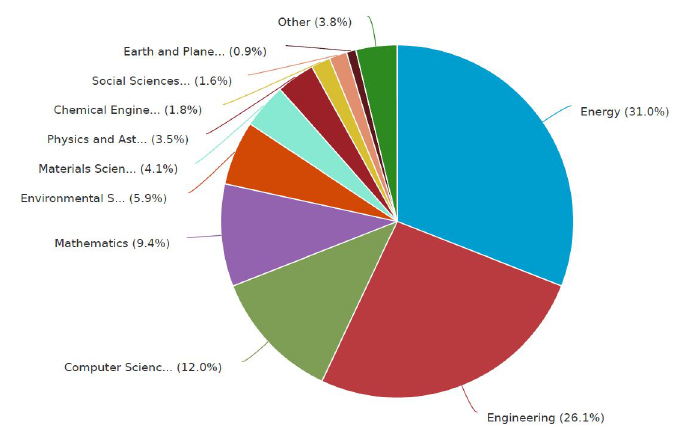
Figure 1. Related publications per subject